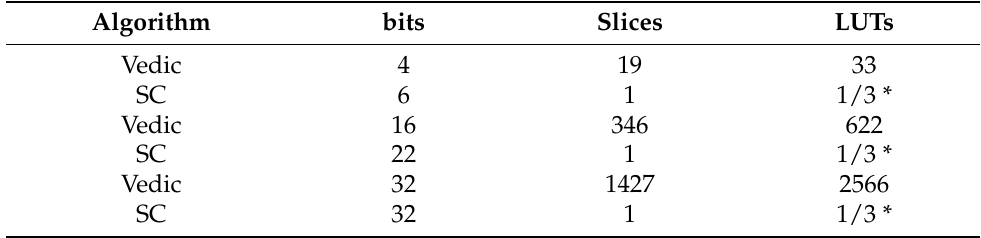
Table 2. Comparison of the number of Field Programmable Gate Array (FPGA) parts used for implementation of the vedic multiplication algorithm [53] and the SC multiplication. (*) The number of LUTs used in SC is considered to be 1/3 of a 6-input LUT, as those in the FPGA used in [53]. Algorithm bits Slices LUTs Vedic 4 SC Vedic